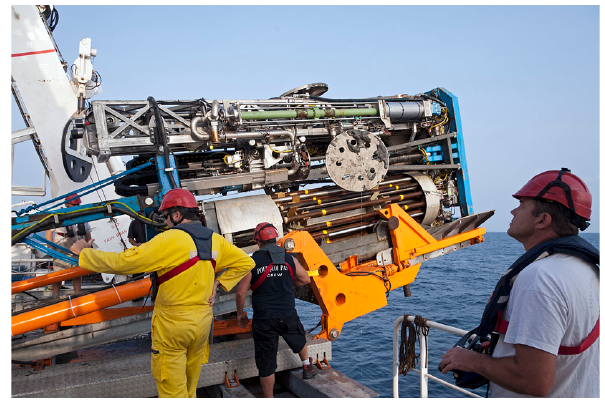
Fig. 2. The sea floor drill rig MeBo during the deployment start from the research vessel RV Pourquoi Pas? in November 2011 (photo: T. Klein, Marum).